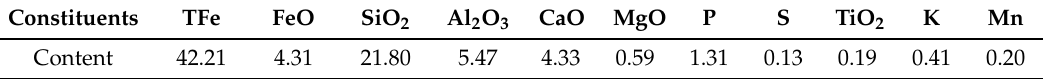
Table 1. Chemical composition of high phosphorus-containing oolitic hematite ore (wt. %). Constituents